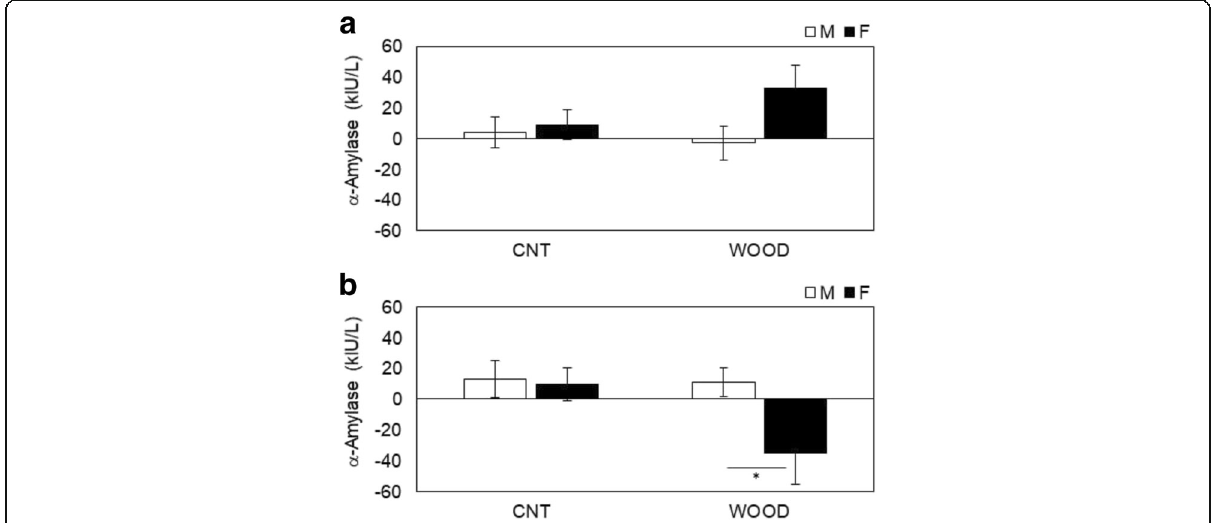
Fig. 3 Variation of salivary α -amylase levels changes a from during-work level to pre-work and b from post-work to during-work. The bar in a de- scribes changes in the salivary α -amylase levels of participants in the control condition (left) and Japanese cedar wood panels (experimental; light) conditions: male participants (white) and female participants (black). CNT indicates the control condition, while WOOD indicates the experimental condition. Differences between conditions were not significant. Data are shown as mean ± SEM. The bars in b describes changes in the salivary α - amylase levels of participants in the control condition (left) and Japanese cedar wood panels (experimental; light) conditions: male participants (white) and female participants (black). Difference in values between male and female participants was significant ( p = 0.031). *statistical signifi- cance ( p < 0.05). Data are shown as mean ±